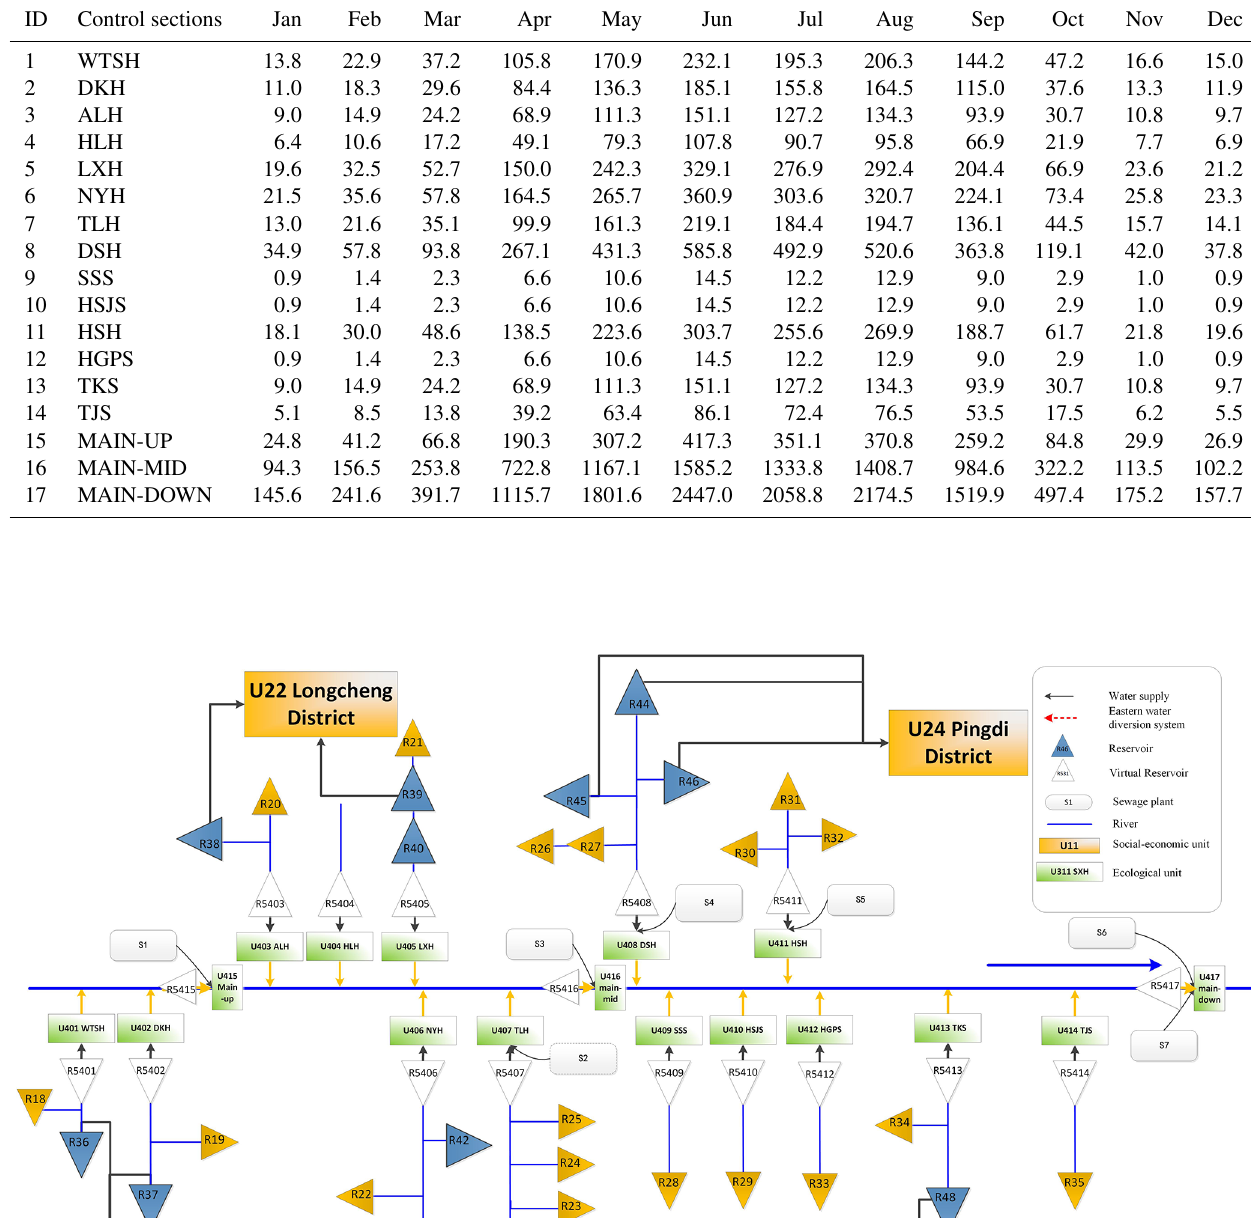
Table 1. Suitable ecological water requirements (10000m 3 ).